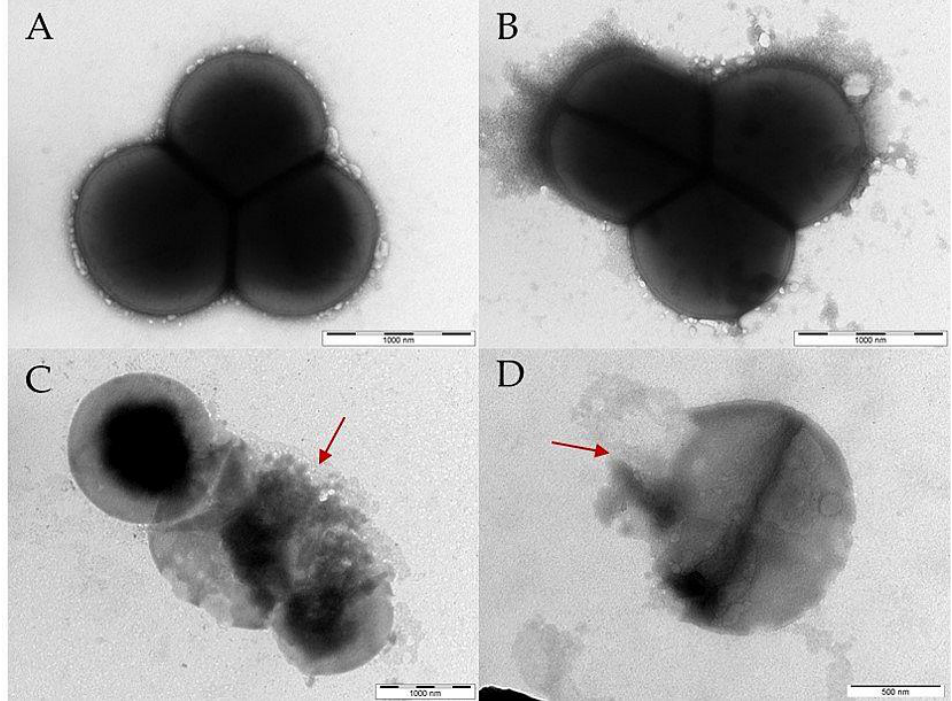
Figure 7. S. aureus cells were imaged using TEM. Disruptions in the bacterial cell wall are high- lighted with a red arrow: ( A ) control untreated S. aureus, ( B ) S. aureus treated with the control poly- with a red arrow: ( A ) control untreated S. aureus , ( B ) S. aureus treated with the control polymer P , mer P, ( C ) S. aureus incubated with PEP, and ( D ) S. aureus incubated with P-PEP . PEP and P-PEP ( C ) S. aureus incubated with PEP , and ( D ) S. aureus incubated with P-PEP . PEP and P-PEP caused the caused the rupture of the cell wall. rupture of the cell